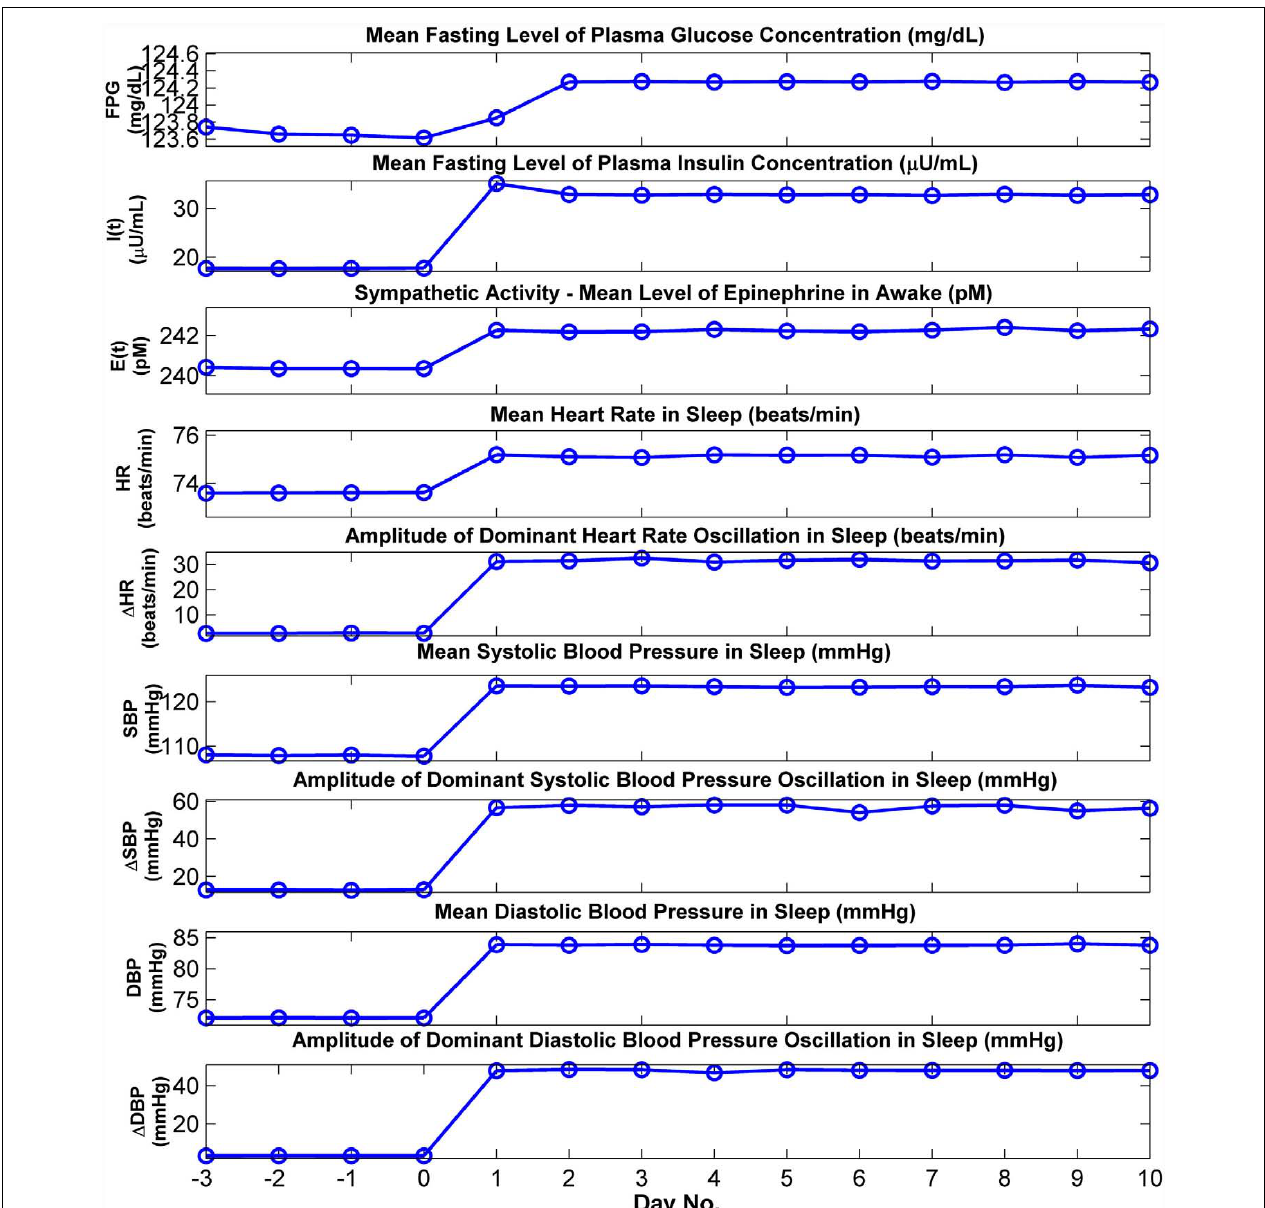
FIGURE 6 | Cardiovascular and metabolic responses predicted by model before, during, and after abrupt transition from normal breathing to OSA. In this simulation, the model is run in normal breathing mode until a steady state has been achieved, and at the end of “Day 0,” the upper airway sensitivity parameter ( S ua ) is abruptly increased to simulate OSA. FPG and FPI: mean levels of plasma glucose and insulin, respectively, calculated from